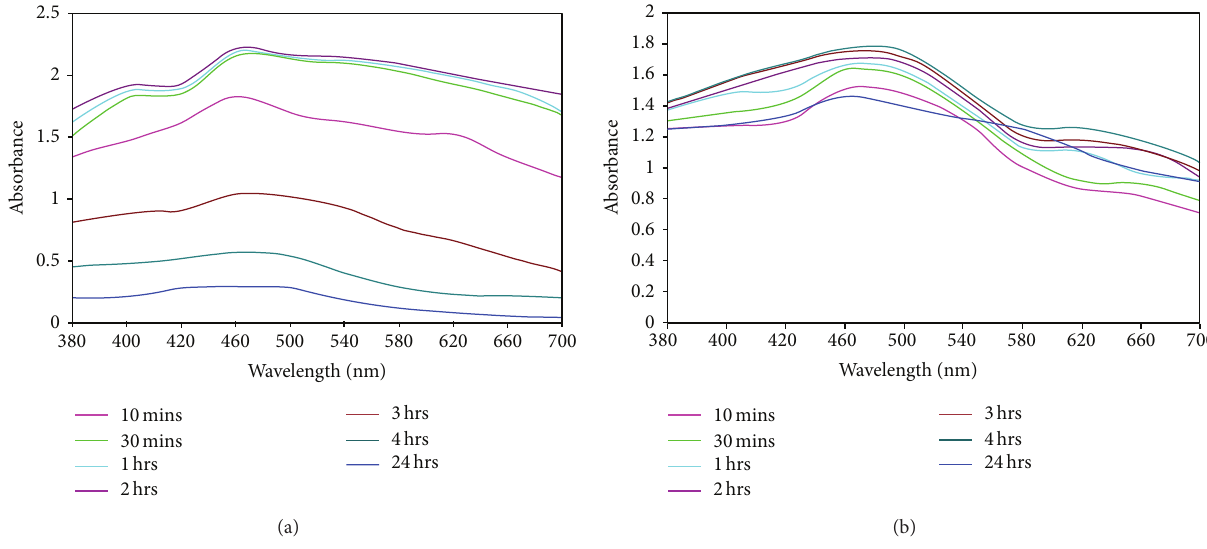
Figure 3: UV-vis spectra of Piper nigrum leaf- (a) and stem- (b) mediated synthesis of silver